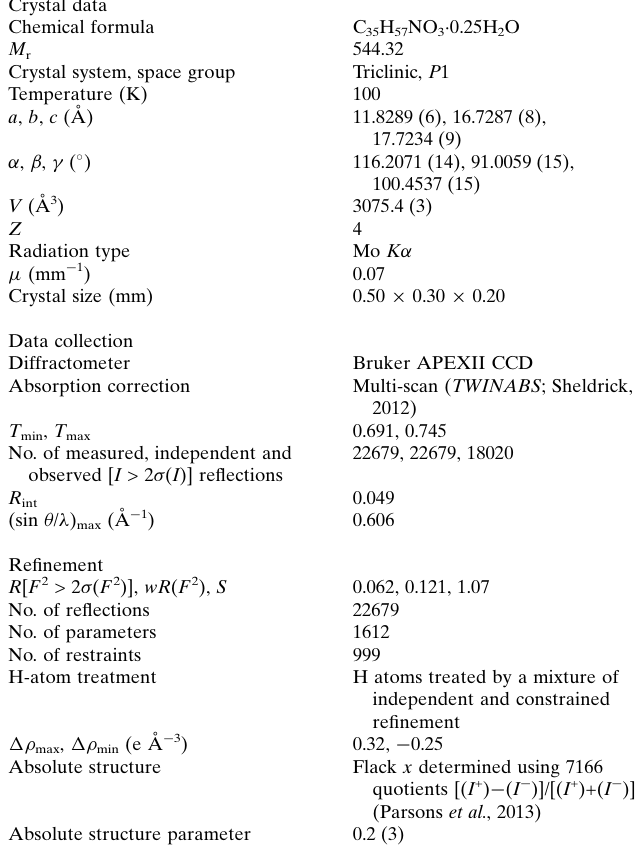
Table 2 Experimental details.